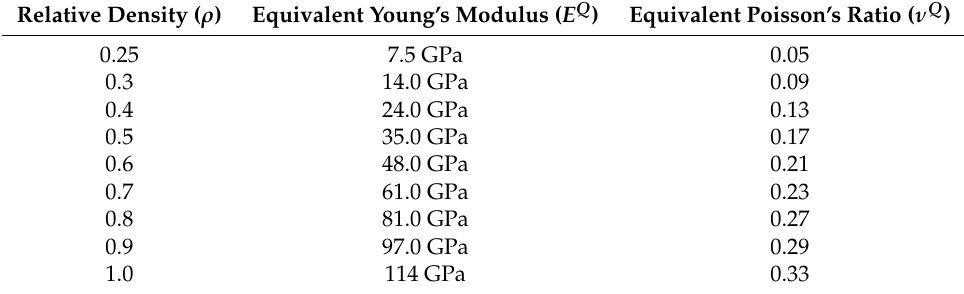
Table 1. Results of numerical homogenization of Schwarz primitive cells: Young’s modulus and Poisson’s